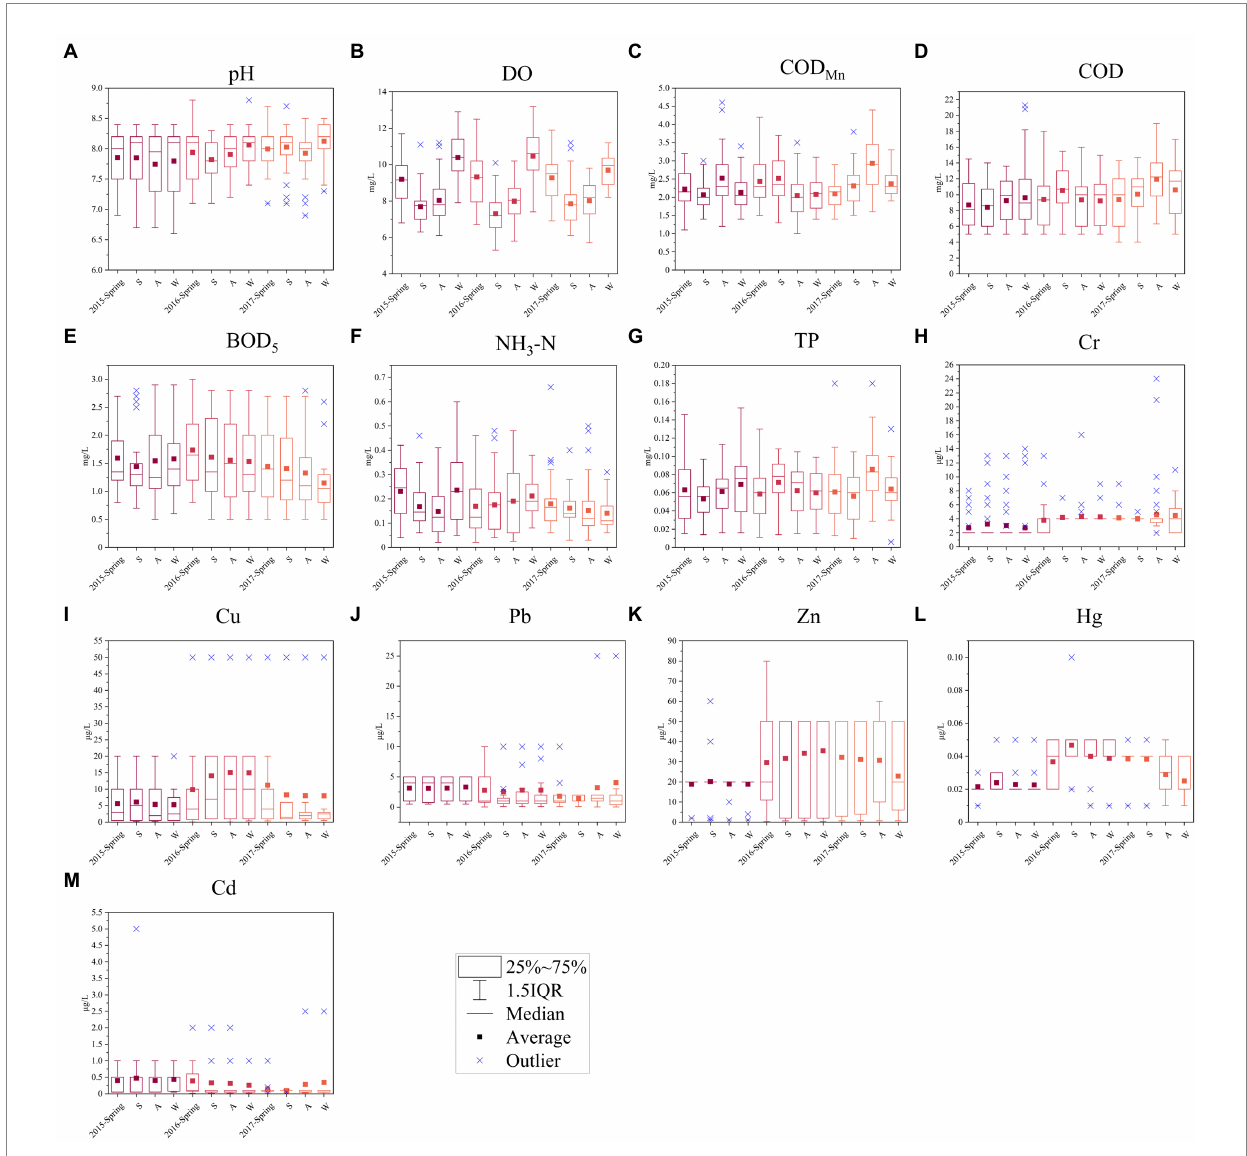
FIGURE 2 Seasonal variations of 13 water quality indicators in the Hanjiang River from 2015 to 2017 at 16 sampling sites: (A) pH, (B) DO, (C) COD Mn , (D) COD, (E) BOD 5 , (F) NH 3 -N, (G) TP, (H) Cr, (I) Cu, (J) Pb, (K) Zn, (L) Hg, (M) Cd (Note: the S, A, and W in the X axis represent summer, autumn, and winter,